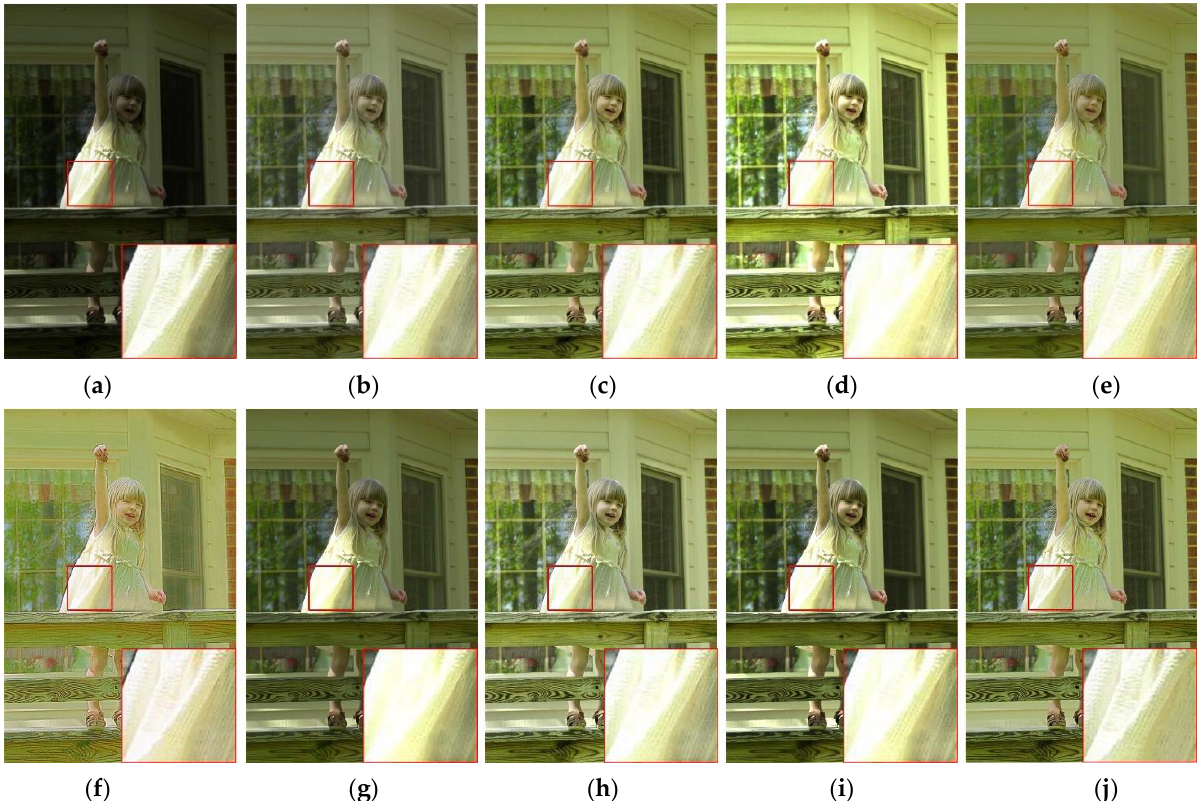
Figure 15. Enhanced results of “Town” image. ( a ) Original image; ( b ) BIMEF; ( c ) MEF; ( d ) LIME; ( e )